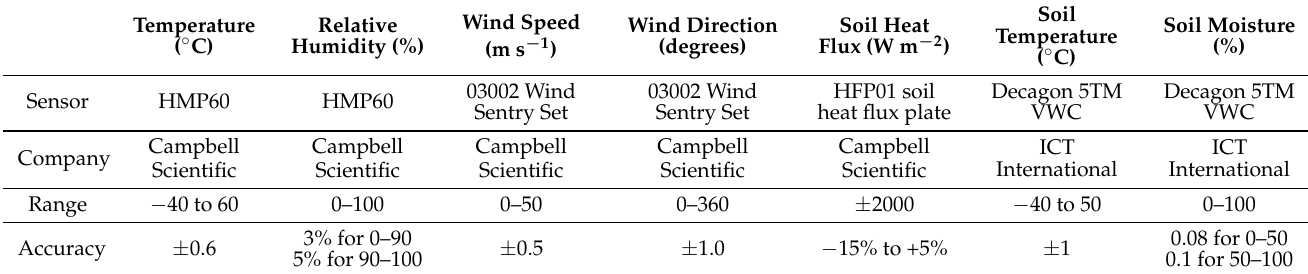
Table 2. Main characteristics of the meteorological instrumentation installed in the HYO.